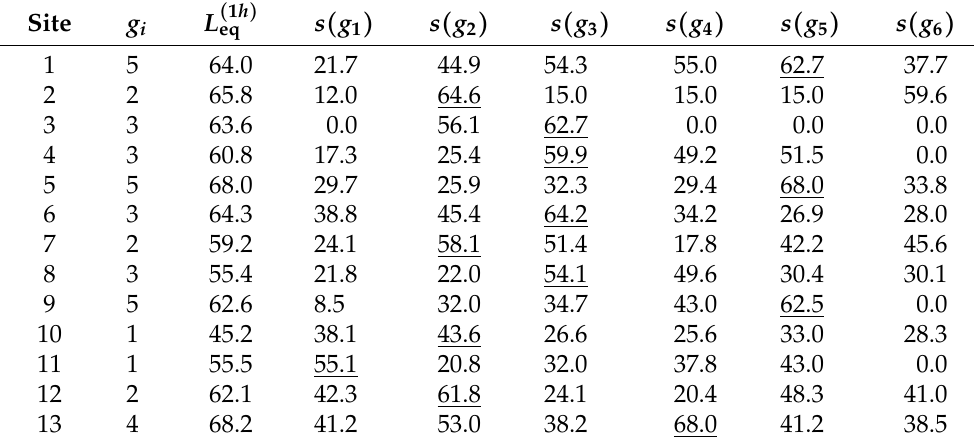
Table 5. The calculated total reference levels (BTNM), L pilot Zone 9 (cf. Table 4). The level contributions from each group, L columns (4th–9th) [86]. All levels are expressed in dB. The underscored values correspond to the largest contribution to each reference level. Here, the number 0.0 stands for vanishingly small